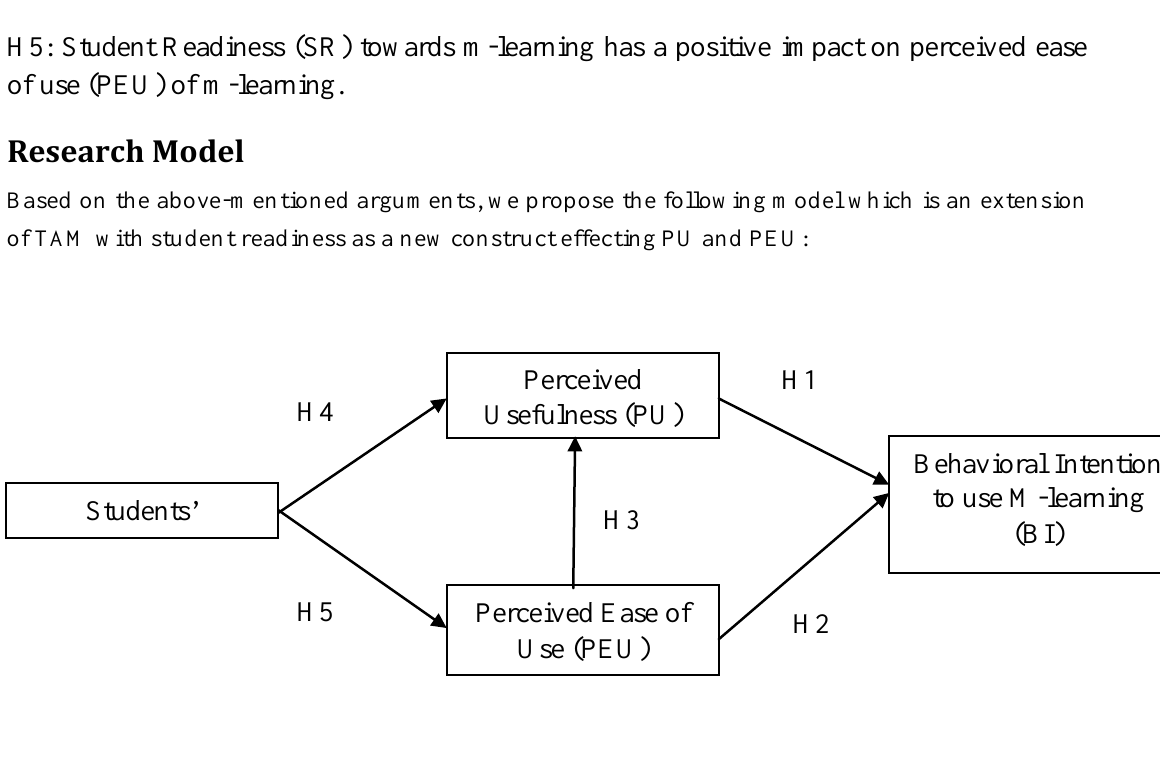
Figure 1. Proposed research model for m-learning adoption among university